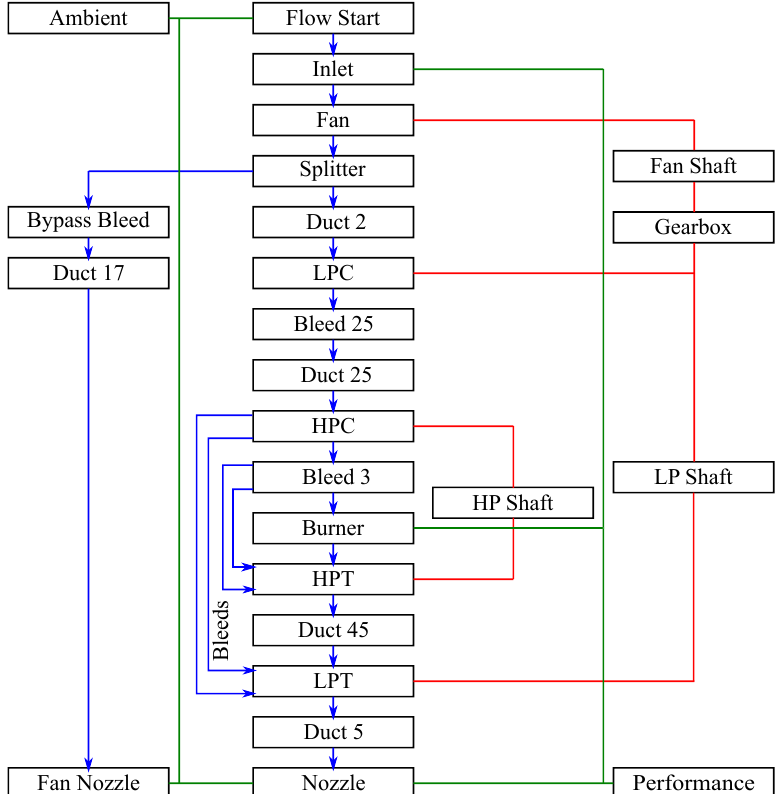
Figure 4. Reference engine model block diagram. Each block is an element in in pyCycle, including the low pressure compressor (LPC), high pressure compressor (HPC), high pressure turbine (HPT), and low pressure turbine